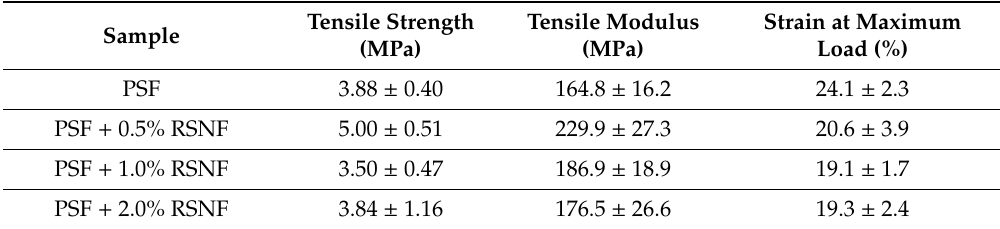
Table 3. Tensile strength properties of polysulfone (PSF) / rice straw nanofibers (RSNF) membranes.